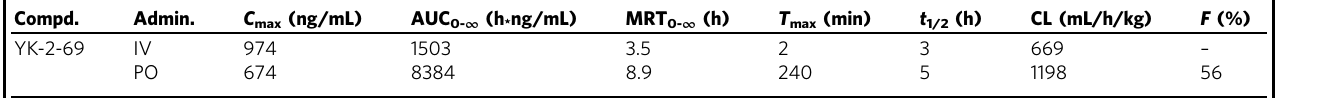
Dose: p.o. at 10mg/kg. Dose: i.v. at 1mg/kg. Source data are provided as a Source Data fi le. C max maximum concentration , AUC area under the plasma concentration-time curve, MRT mean residence time, t 1/2 half-life, CL clearance, F oral bioavailability. a Values are the average of three